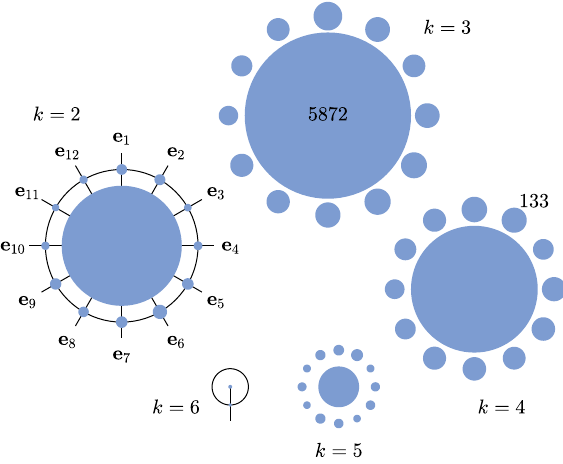
Figure 3. The 54 circles represent the initial points in use. The number of times each initial point is selected (e.g., 5872, 133 etc.) for a power flow is expressed by the area of each circle. Occurrences are counted from the 16,000 test power flows. ( P ∆ = 500 W). The larger central circles are for S (cid:48) [ k ] . The smaller circles that form planets are for S (cid:48) [ k , l , m ] , which have m = 1.